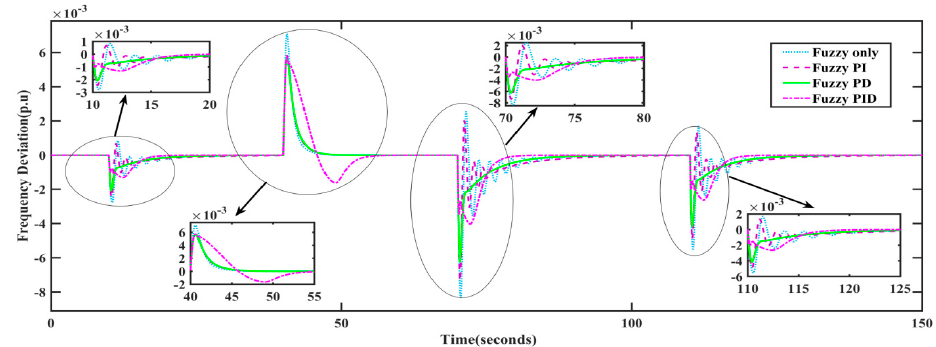
Figure 21. Dynamic response comparison of different control configurations of IHPS frequency change for the random load disturbance. Table 5. Optimal parameters for both control 1 and 2 using ABC algorithm for Case 1 (1% step change in